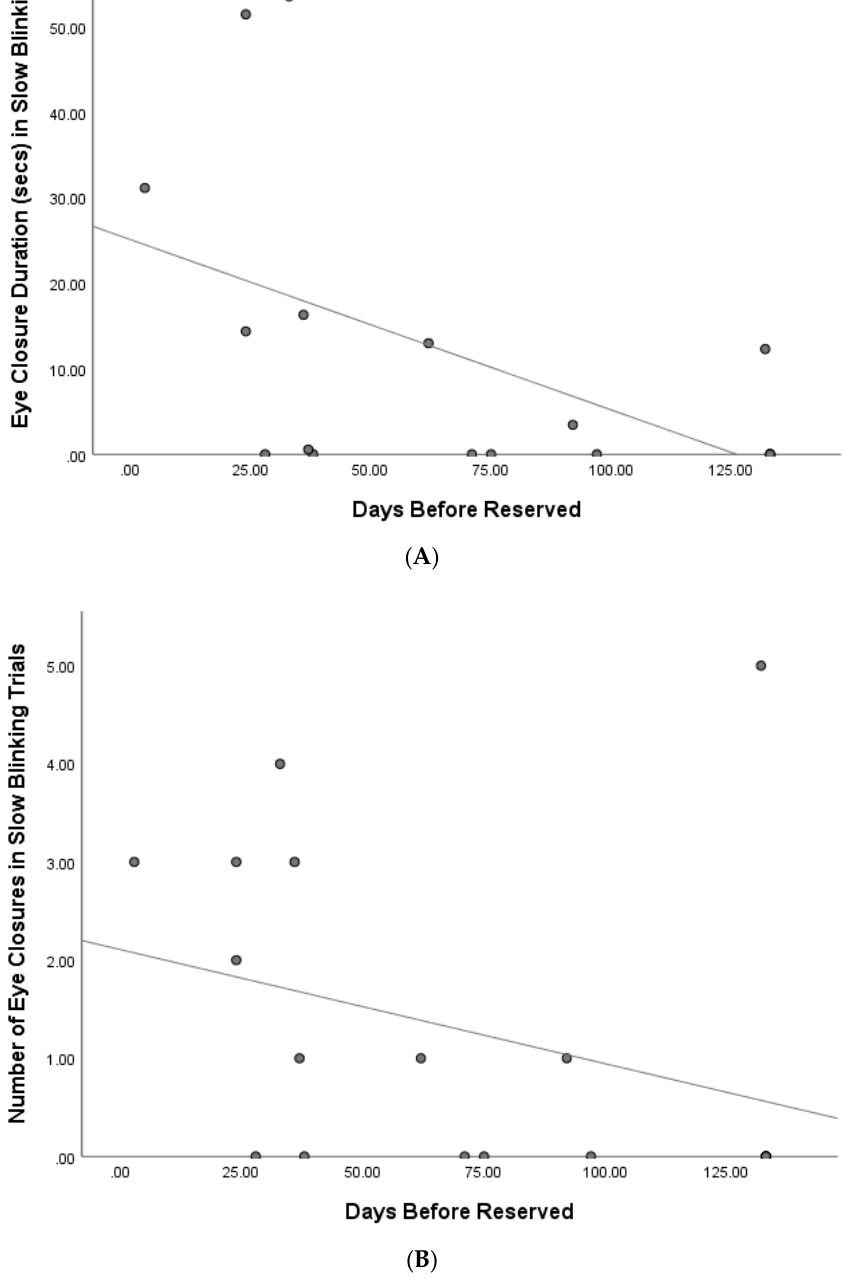
Figure 4. ( A ) Relationship between duration of cat eye closures and days before cats were reserved for rehoming; ( B ) relationship between the number of cat eye closures and days before cats were reserved for rehoming.